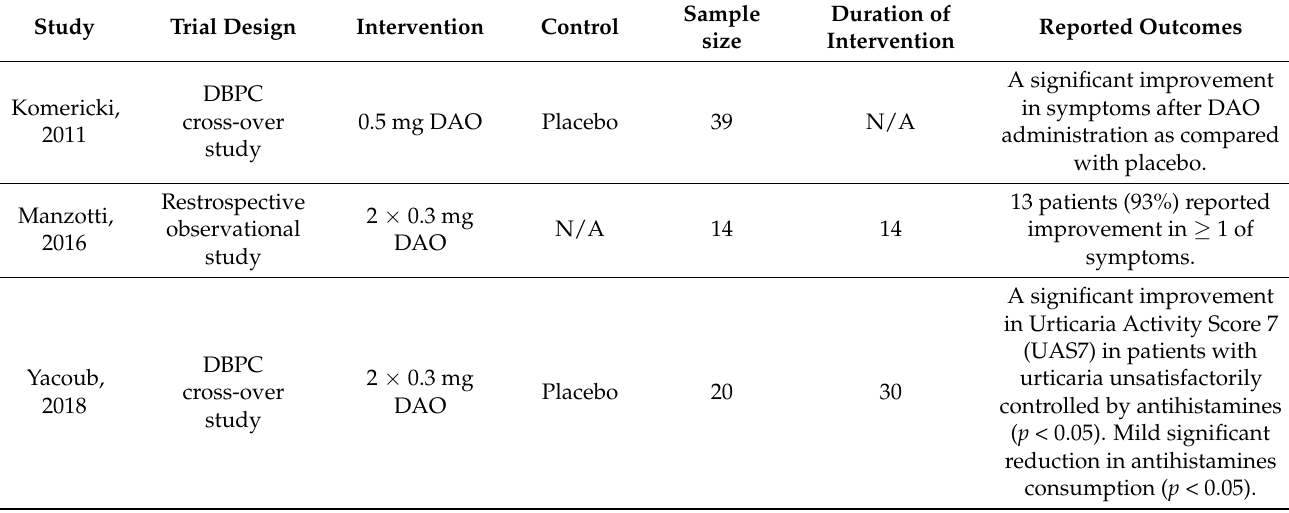
Table 6. Summary of clinical studies testing the effects of exogenous supplementation of diamine oxidase obtained from porcine kidneys. DAO—diamine oxidase; DBPC—double-blind placebo controlled; N/A—not available; 5-HT—5 hydroxytryptamine; UAS7—Urticaria Activity Score 7; NS—non-significant; C1—before treatment (consultation no. 1); C2—after treatment (consultation no. 2)